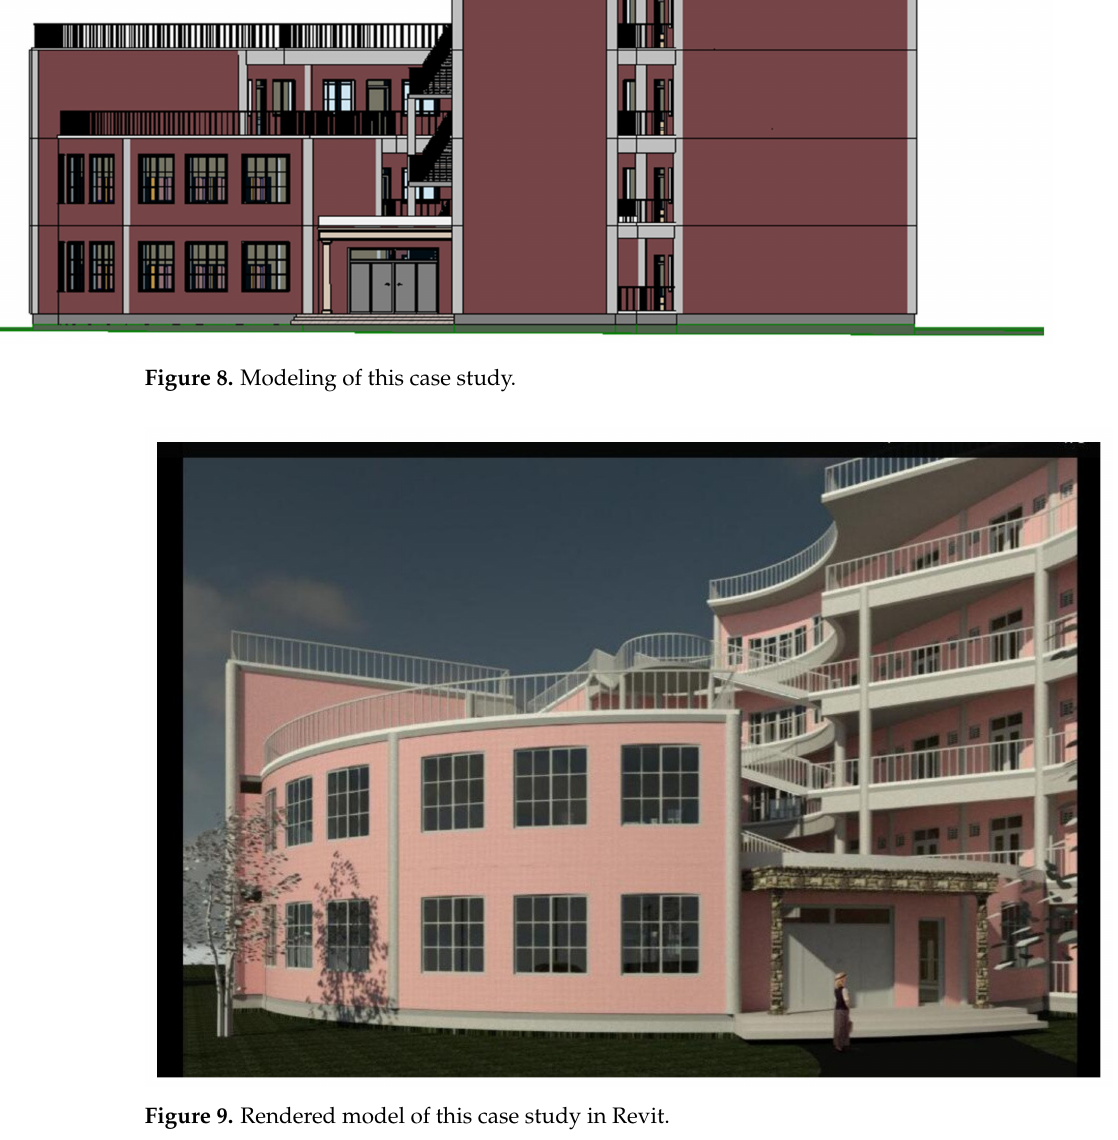
Figure 9. Rendered model of this case study in